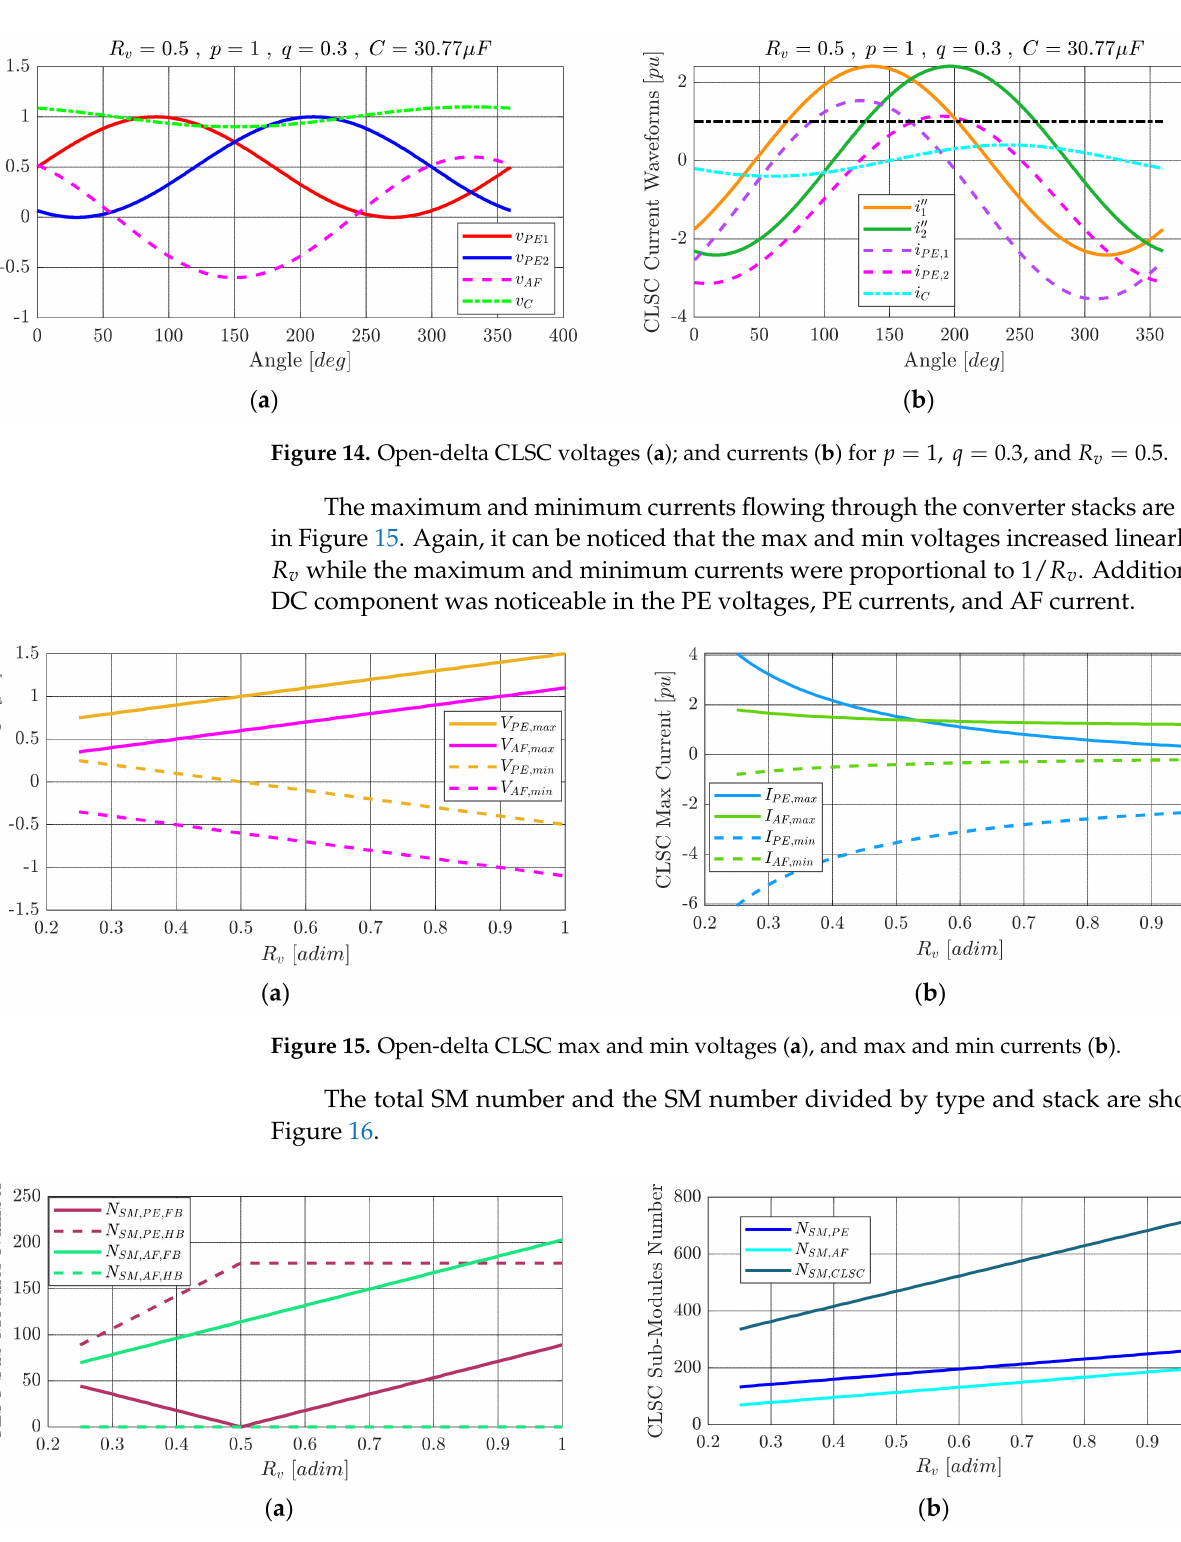
Figure 16. Open-delta CLSC SM number divided by type ( a ), and divided by stack ( b ). The switch number and the total switch sizing power are reported in Figure 17.